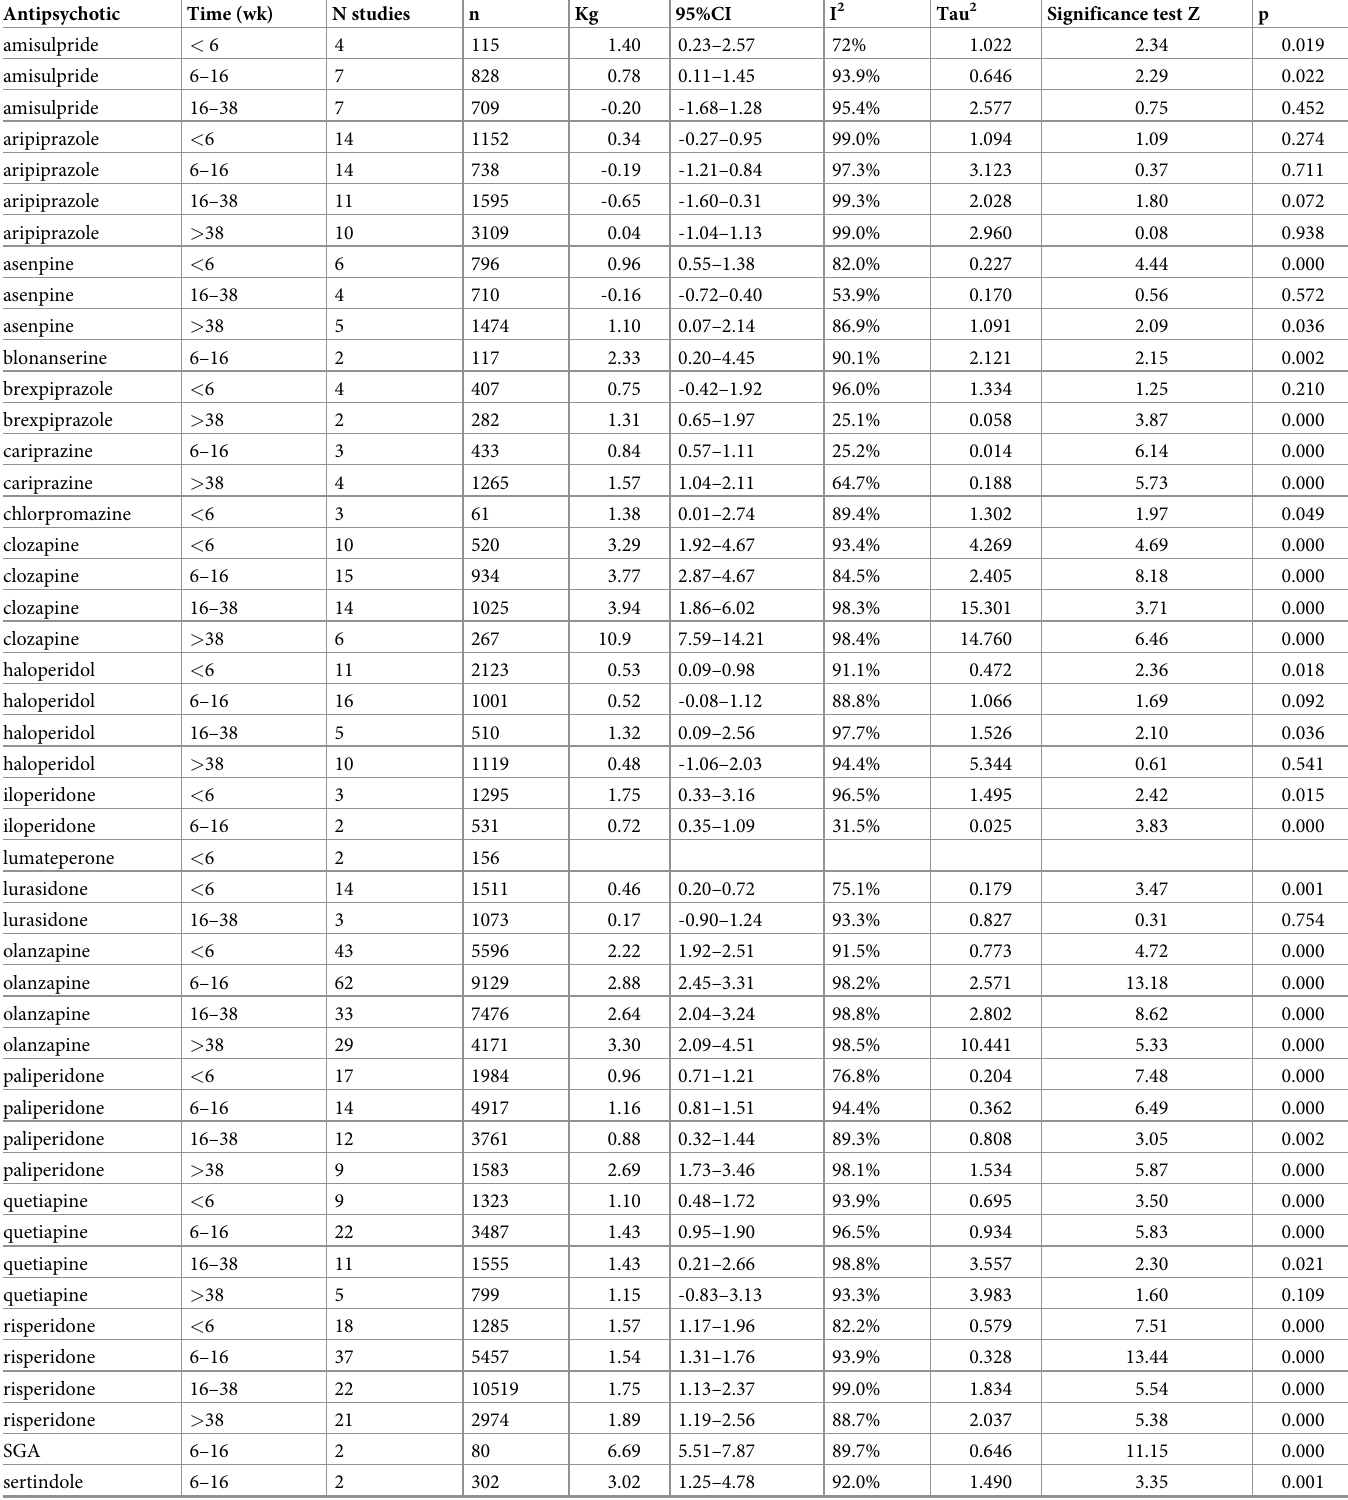
Table 2. Results AP-switch